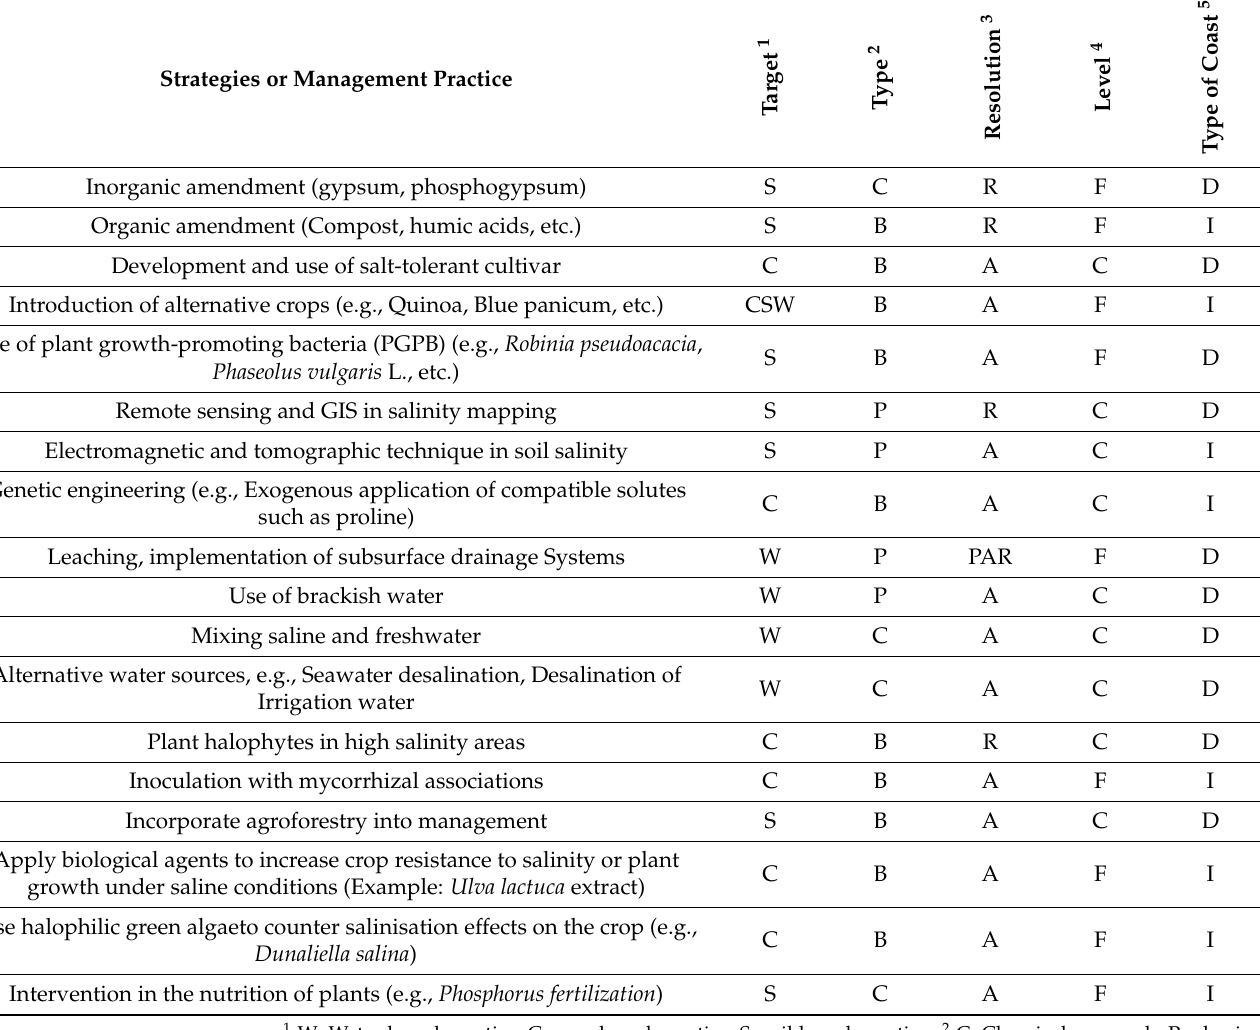
Table 1. Practices and strategies adopted at the farm and territorial levels to tackle soil salinization in